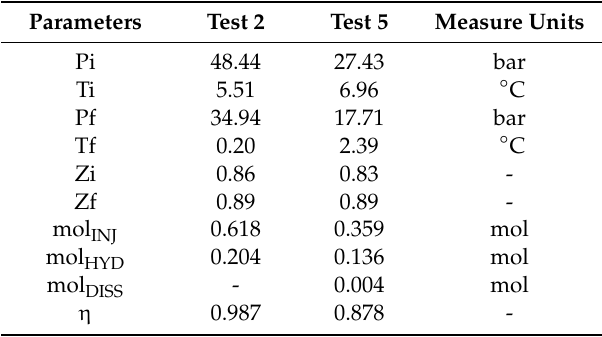
Table 2. Parameters related to Test 2 (with CH 4 ) and Test 5 (with CO 2